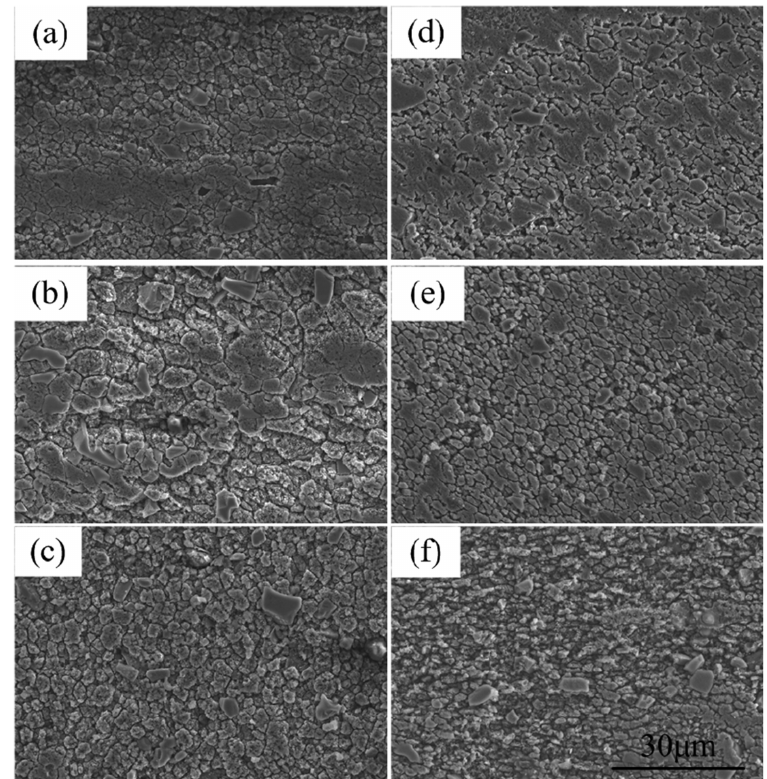
Figure 4: Grains at different regions: (a) upper, (b) middle and (c) lower region of air cooling FSP specimen, (d) upper, (e) middle and (f) lower region of water cooling FSP specimen.